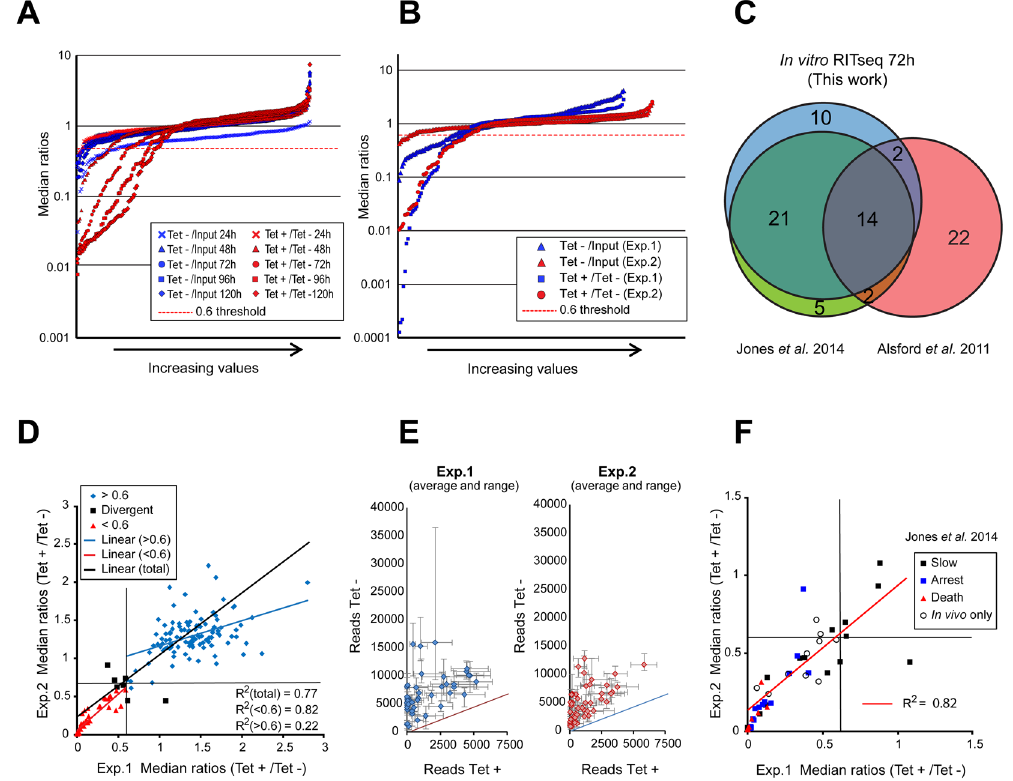
Figure 2. Intrinsic reproducibility and correlation between in vivo and in vitro RITseq. ( A ) Bootstrap median ratios of uninduced/input (Tet − /input) and induced/uninduced (Tet + /Tet − ) in triplicate for each time point of the in vitro RNAi screen, arranged in increasing order. Reads were normalized as reads per million (RPM). ( B ) Bootstrap median ratios of uninduced/input (Tet − /input) and induced/uninduced (Tet + /Tet − ) of each in vivo experiment arranged in increasing order. ( C ) Venn diagram showing the overlap between the number of loss-of-fitness PK depletions identified with the kinome-wide in vitro RITseq screen after 72 h of RNAi induction and the two in vitro studies covering the PKs of T. brucei available in the literature 6, 12 at the same time point. ( D ) Bootstrap medians of ratios calculated between induced and uninduced in vivo samples plotted per RNAi target assessing regression of both biological replicates. Highlighted in red are those with a loss of fitness in the two experiments, in black those with a loss of fitness in one only, and blue those without a loss of fitness. ( E) Breakdown of results for loss of fitness RNAi lines within each of the individual in vivo biological replicates. Depicted average and range of normalized counts for the 6 mice analyzed per condition (Tet + or Tet − ) and per RNAi target. ( F ) As panel D but focusing on the RNAi cell lines giving a loss of fitness (ratio < 0.6) in at least one of the 2 biological replicates. Includes depicted correlation with the in vitro screen previously published by Jones et al . 6 with the same library (slow growth, cell cycle arrest or death), highlighting PKs whose depletion produced loss of fitness only in vivo